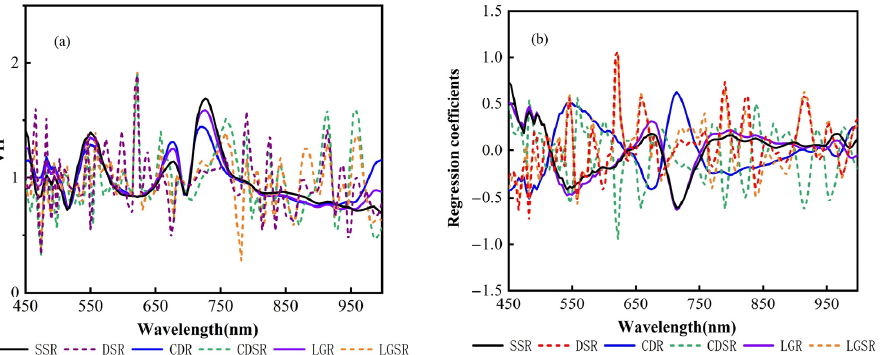
Figure 8. The PLSR model of leaf reflectance at 450–998 nm was used to analyze the weights of the variables related to canopy SPAD evaluation in the different data sets. ( a ) The VIP scores across different spectral regions for each PLSR model in different data sets, ( b ) the regression coefficients at 450–998 nm for the summer maize SPAD value assessment using the PLSR model in different